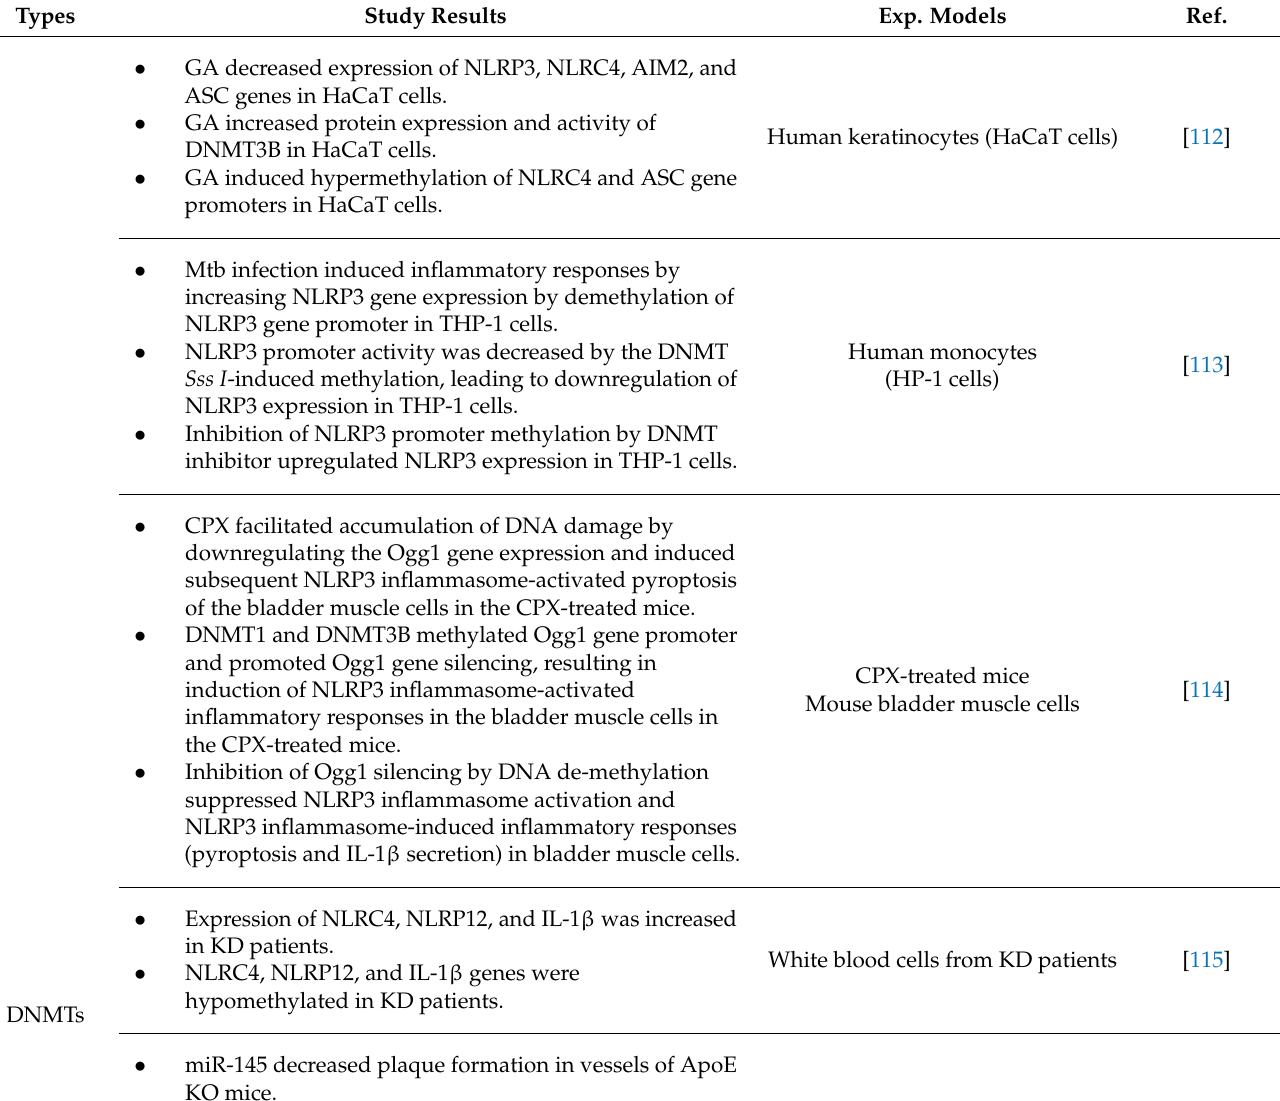
Table 2. Summary of functional cooperation between MTs and